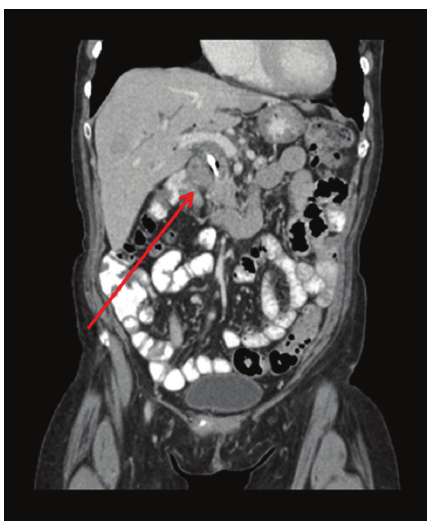
Figure 4: Contrast-enhanced coronal CT image demonstrates an ill-defined mass in the porta hepatis causing compression of the portal vein and common bile duct (red